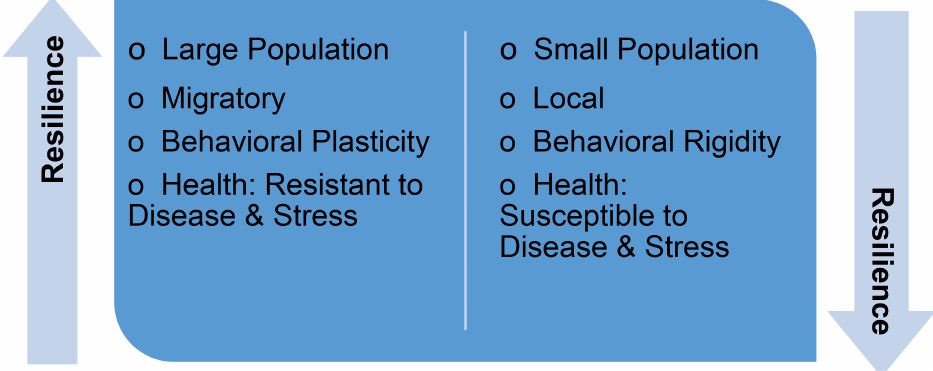
Fig 1. The resilience of marine mammal populations can be assessed based on population size, range, behavioral plasticity, and health. Each of these 4 metrics can be ranked from 1 to 5, with a rank of 1 representing large, migratory populations exhibiting behavioral plasticity (including diet) and resistance to disease and stress and a rank of 5 representing the opposite.